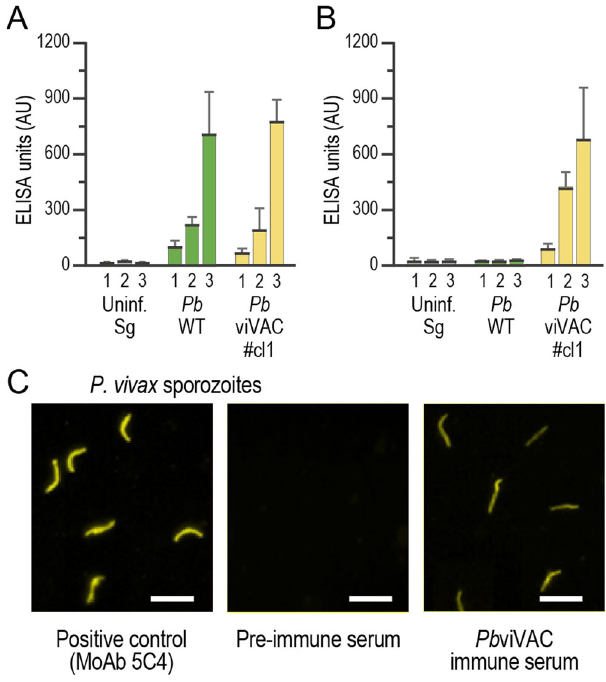
Fig. 4 Humoral immune responses induced by immunization with Pb viVac. Total IgG titers against the Pb CSP (A) or the Pv CSP (B) repeat sequences in mouse plasma after prime (1), fi rst (2) and second boost (3) immunization with either a mock control of uninfected mosquito salivary glands (grey), with Pb WT (green) or with Pb viVac (yellow) sporozoites; (C) Representative immuno fl uor- escence microscopy images showing the binding of serum from Pb viVac-immunized mice to Pv sporozoites. AU: arbitrary units; Scale bar: 20 µm. The black lines/bars and grey lines correspond to mean and standard error of the mean,